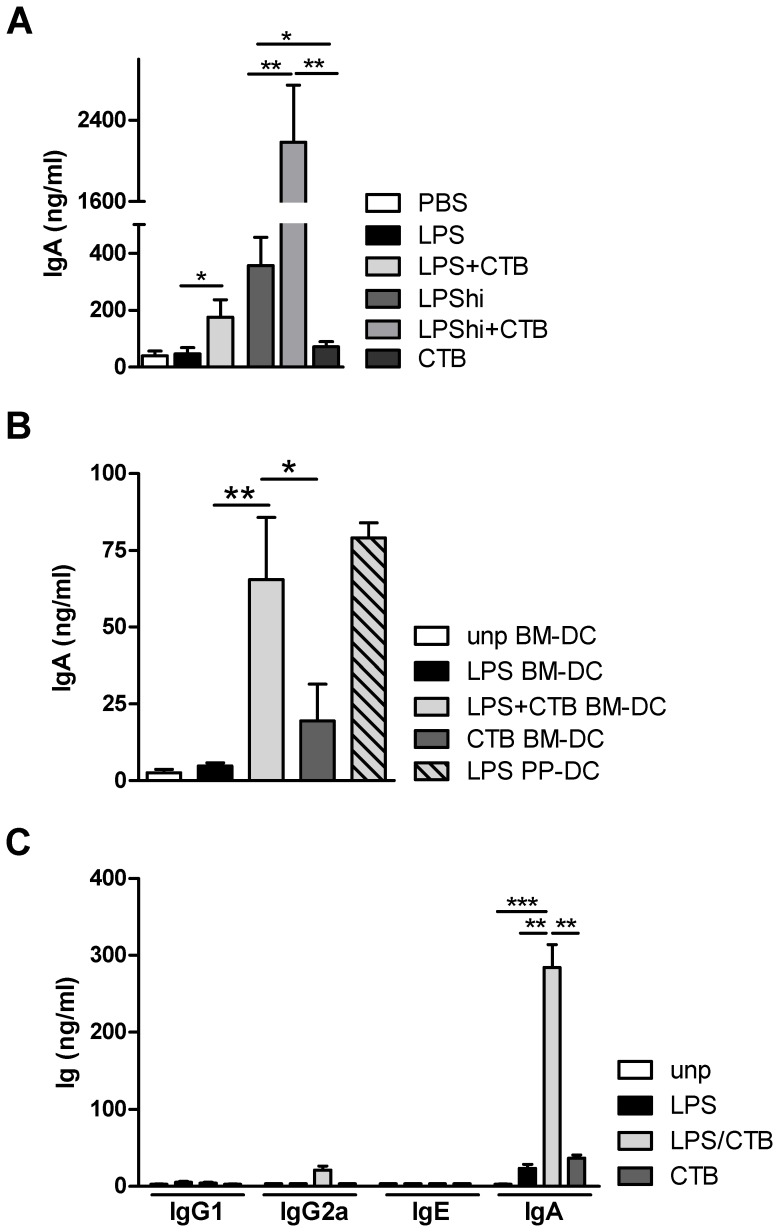
CTB/LPS-primed BM-DCs promote IgA production in vitro.BM-derived DCs were cultured for 8 days with GMCSF, pulsed overnight with PBS, LPS (1 ng/ml) +/− CTB (10 µg/ml) or CTB alone, and then co-cultured with splenic B cells (ratio 1∶1) and anti-IgM Fab-fragments (10 µg/ml). After 7 days, IgA levels were determined by ELISA. (A) BM-DC and B cells of Balb/c background were used for the co-culture. In addition to the conditions described, a high concentration (100 ng/ml) of LPS was used to pulse the BM-DC (B) Besides BM-DC, PP-DC were used to put in co-coculture with B cells (all of C57/Bl6 background) (C) In addition to IgA, also other Immunoglobulin isotypes were measured in supernatant of cocultures (Balb/c) by ELISA. Mean+sem of at least 5 individual experiments are shown. * P<0.05, ** P<0.01, *** P<0.001.